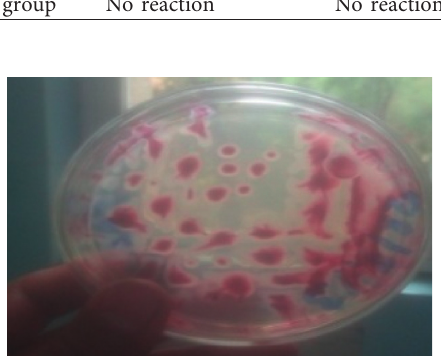
Figure 1: R. solanacearum colonies with its characteristic